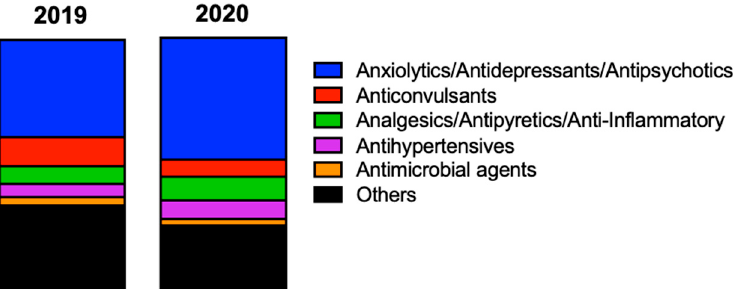
Figure 6. Characterization of the pharmacotherapeutic groups most involved in potential drug intoxications in the Algarve region in 2019 and 2020. Comparing 2019 and 2020, the distributions were as follows: anxiolytics/antidepressants/antipsychotics (38.74% vs. 48.40%), anticonvulsants (11.49% vs. 6.85%), analgesics/antipyretics/anti-inflammatory (7.04% vs. 9.50%), antihypertensives (5.38% vs. 7.29%), antimicrobial agents (3.34% vs. 2.65%), others (34.01% vs. 25.30%).